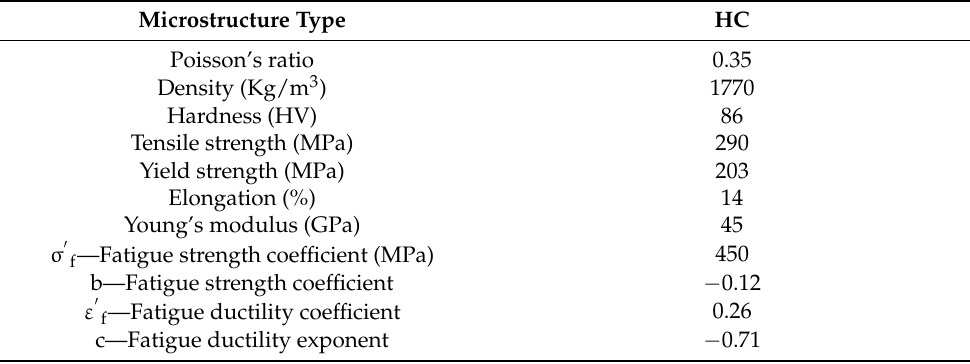
Table 2. AZ31B-F mechanical properties, data from